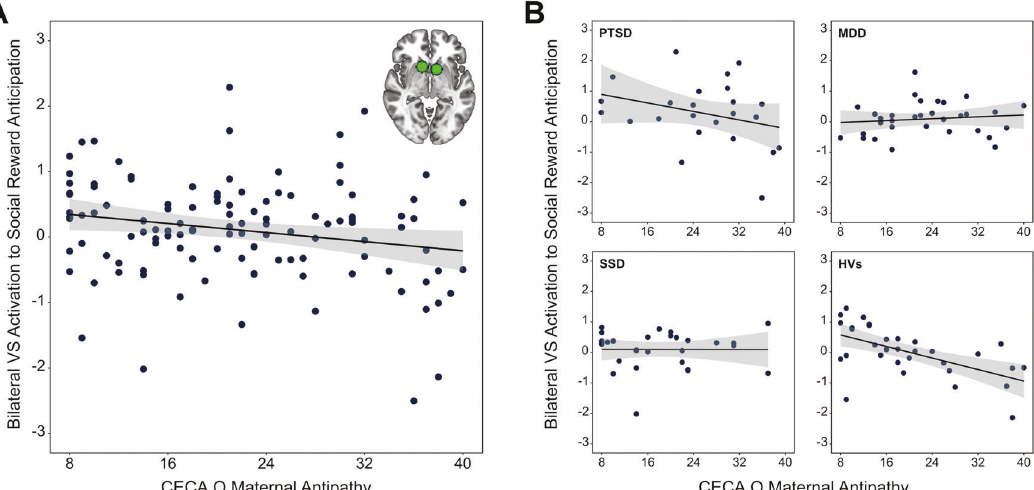
Fig. 2 Moderation of association between childhood maternal antipathy and bilateral ventral striatal activation to social reward anticipation. A Association between childhood maternal antipathy and bilateral ventral striatal (VS) blood oxygen level-dependent (BOLD) response to social reward vs. neutral anticipation in the whole transdiagnostic sample after exclusion of one outlier. B Group af fi liation moderates the association between childhood maternal antipathy and bilateral VS BOLD response to social reward anticipation with signi fi cant negative associations found in participants with posttraumatic stress disorder (PTSD) and healthy volunteers (HVs), and no association found in participants with major depressive disorder (MDD) and somatic symptom disorder (SSD). Please note that the scatterplots depict associations after the exclusion of one outlier. Please refer to Supplementary Fig. S2 for the corresponding scatterplots including the